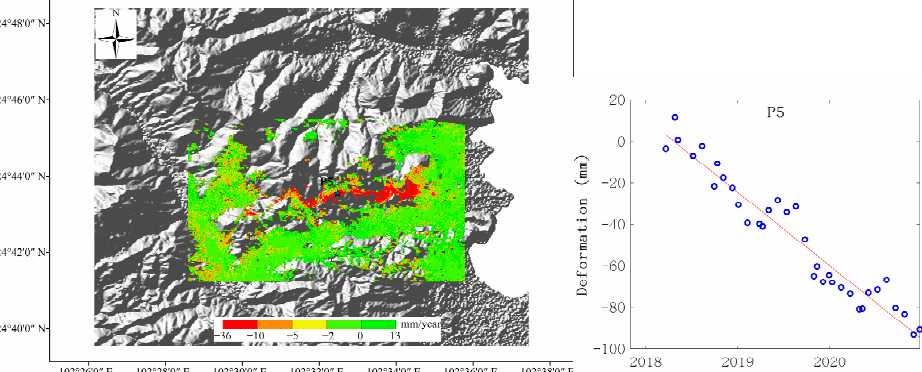
Figure 9. Deformation rate in the mining area and time series cumulative settlement diagram of P5.